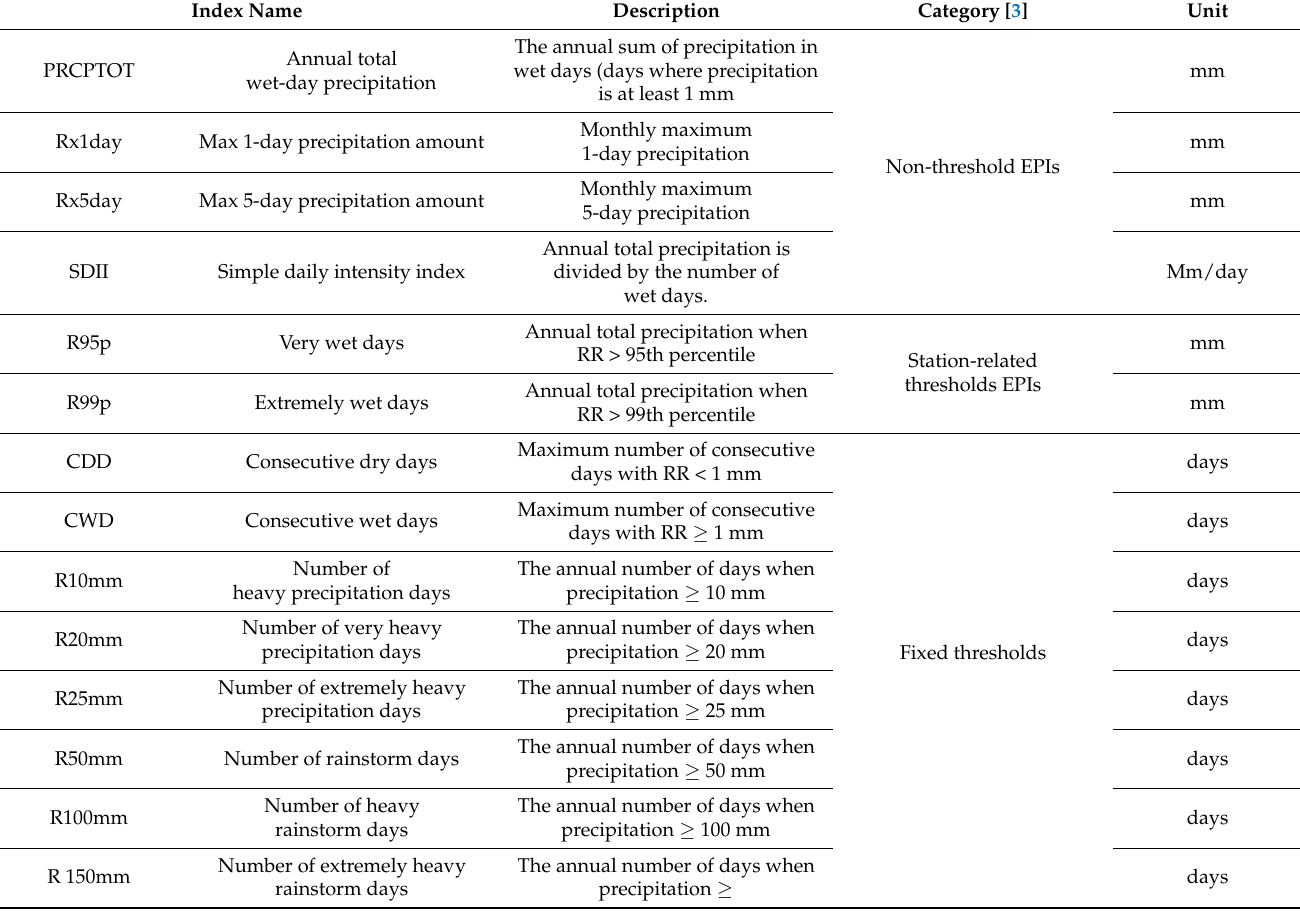
Table 3. Description of the extreme precipitation indicators (EPIs) used in this